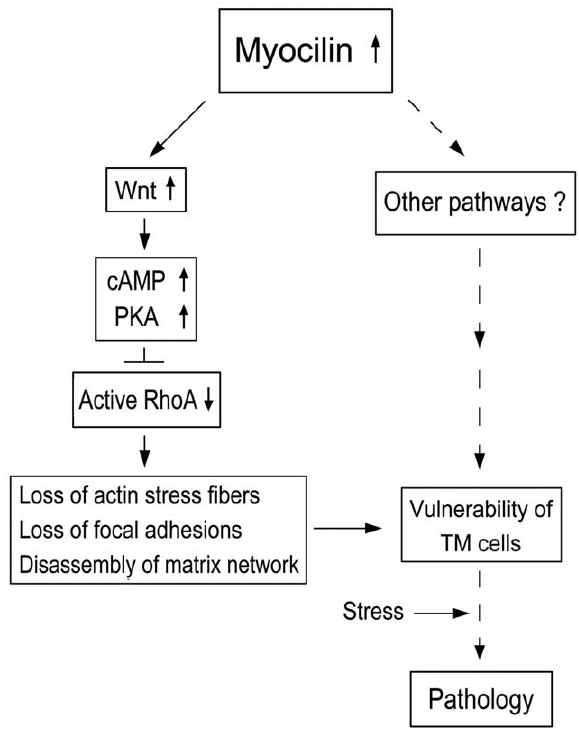
Figure 6. A schematic model of possible events in human TM cells triggered by upregulation of myocilin. Myocilin, when moderately upregulated, induces Wnt activation, and the downstream cAMP/PKA activation and RhoA inactivation, resulting in a loss of actin stress fibers and focal adhesions and disassembly of matrix network. These changes or other pathways may affect the integrity of TM cells, rendering them more susceptible to additional stress or challenge on a chronic, long-term basis, leading to pathologic consequences. Other intermediate mediators or pathways are yet to be identified. Dotted lines indicate steps that have not been investigated in the present work or our previous investigation [19–21].